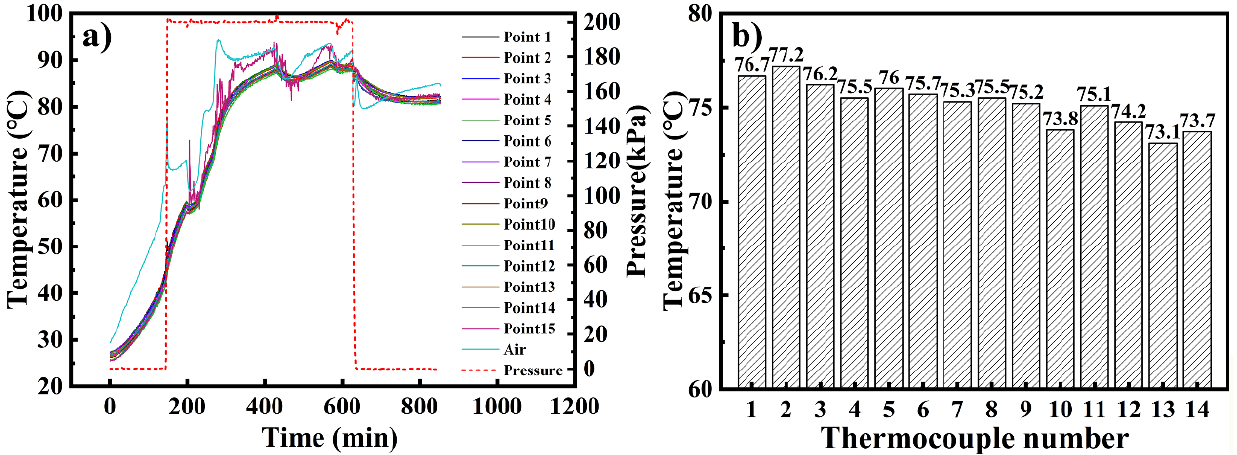
Figure 4. Temperature history ( a ) for the entire process and ( b ) at 300 min.